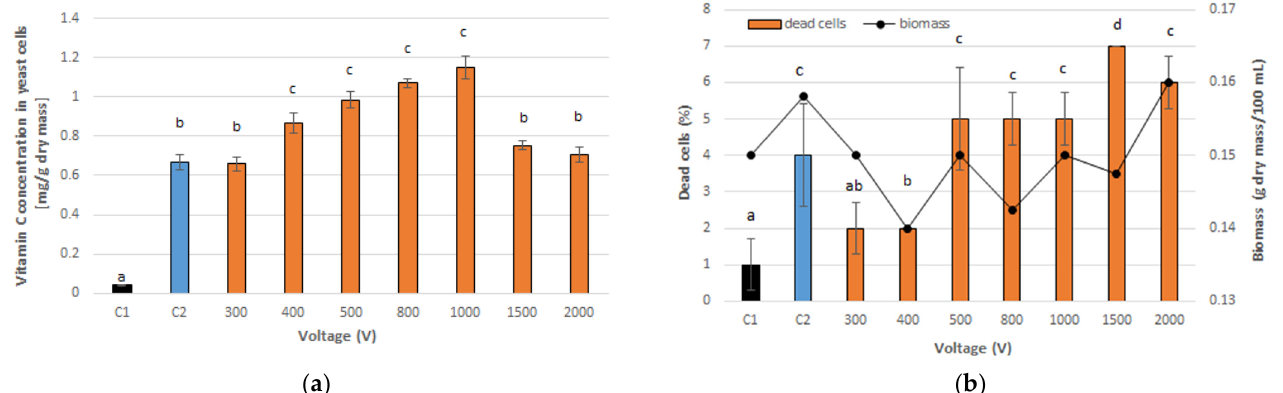
Figure 2. Effect of voltage on vitamin C accumulation in yeast cells ( a ). Effect of voltage on the number of dead yeast cells and on biomass ( b ). C1—control culture without vitamin C added to the medium and PEF treatment, C2—control culture with vitamin C added to the medium (5 mg/mL medium) and without PEF treatment, orange bars—cultures treated with PEF (vitamin C, 5 mg/mL medium; pulse width of 10 µs; treatment time, 10 min; number of pulses, 600; after 20 h of cultiva- tion). Each value is the mean ± standard deviation ( n = 3). Bars with the same letter (a–d) are not significantly different ( p < 0.05).